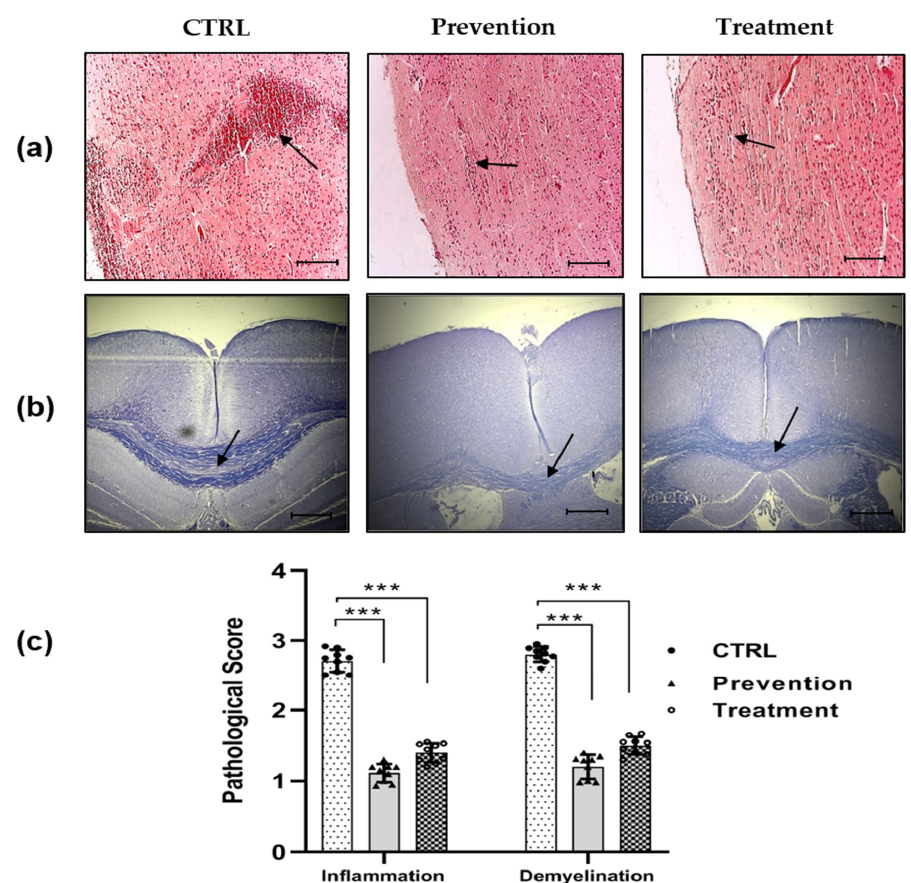
Figure 2. MOG administration ameliorates CNS inflammation and demyelination. Histopathological evaluation of CNS from all the mice was performed. Brain sections from each group were collected on day 25 post-immunization, fixed in paraformaldehyde, and embedded in paraffin. Five µ m sections from different regions of the brain from each of the groups were stained with ( a ) Hematoxylin and eosin, to enumerate infiltrating leukocytes, and ( b ) Luxol fast blue to assess demyelination. Scale bars: 100 μ m. ( C ) CNS inflammatory foci and infiltrating inflammatory cells were quantified. Pathological scores, including inflammation and demyelination, were analyzed and shown as mean scores of pathological inflammation or demyelination ± SEM. *** p < 0.001, when compared with control group. Mice were divided into three groups: 1. Control group (CTRL, n = 9); 2. Prevention group with MOG (n = 9); 3. Treatment group with MOG (n = 9).